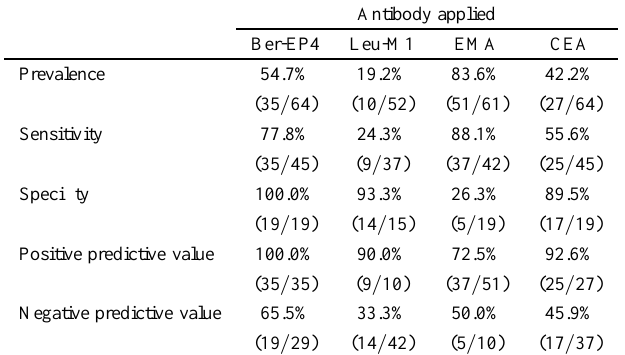
Results of immunocytochemistry in equivocal effusions